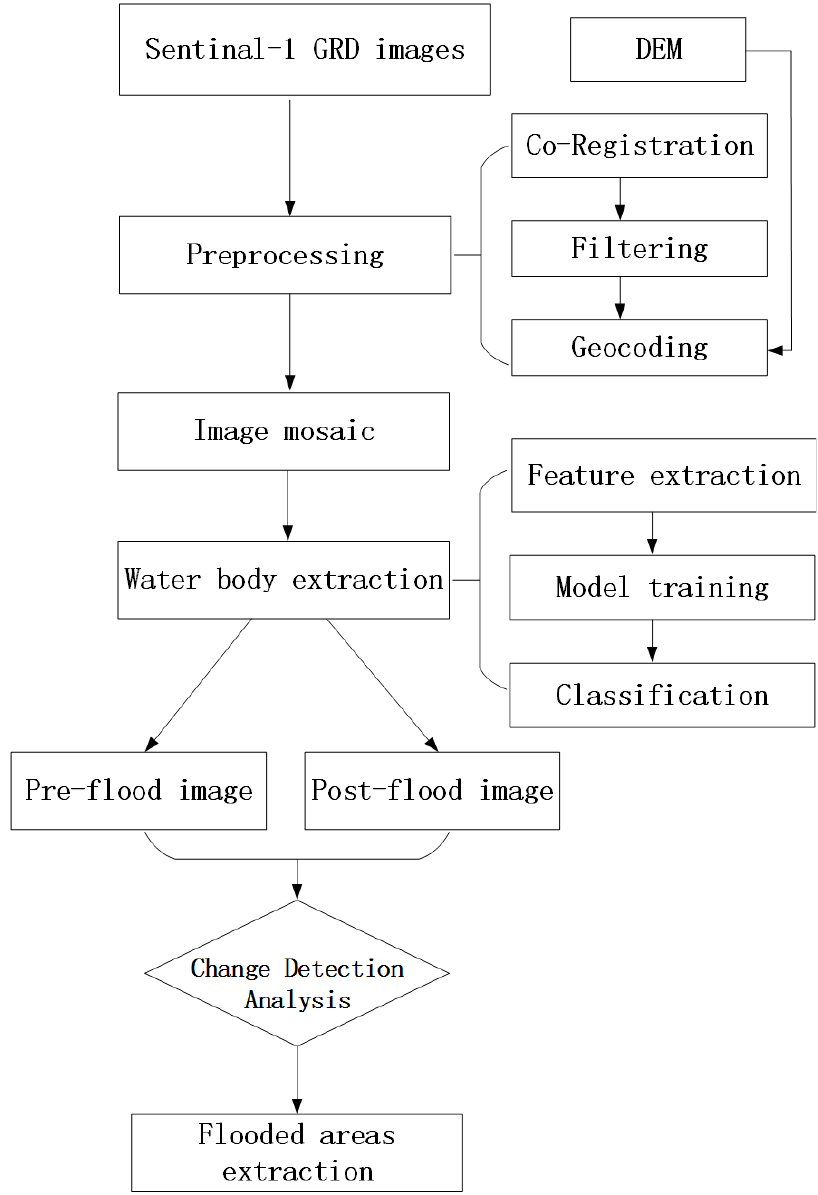
Figure 5. Process of flooded area extraction in this work using remotely sensed data.